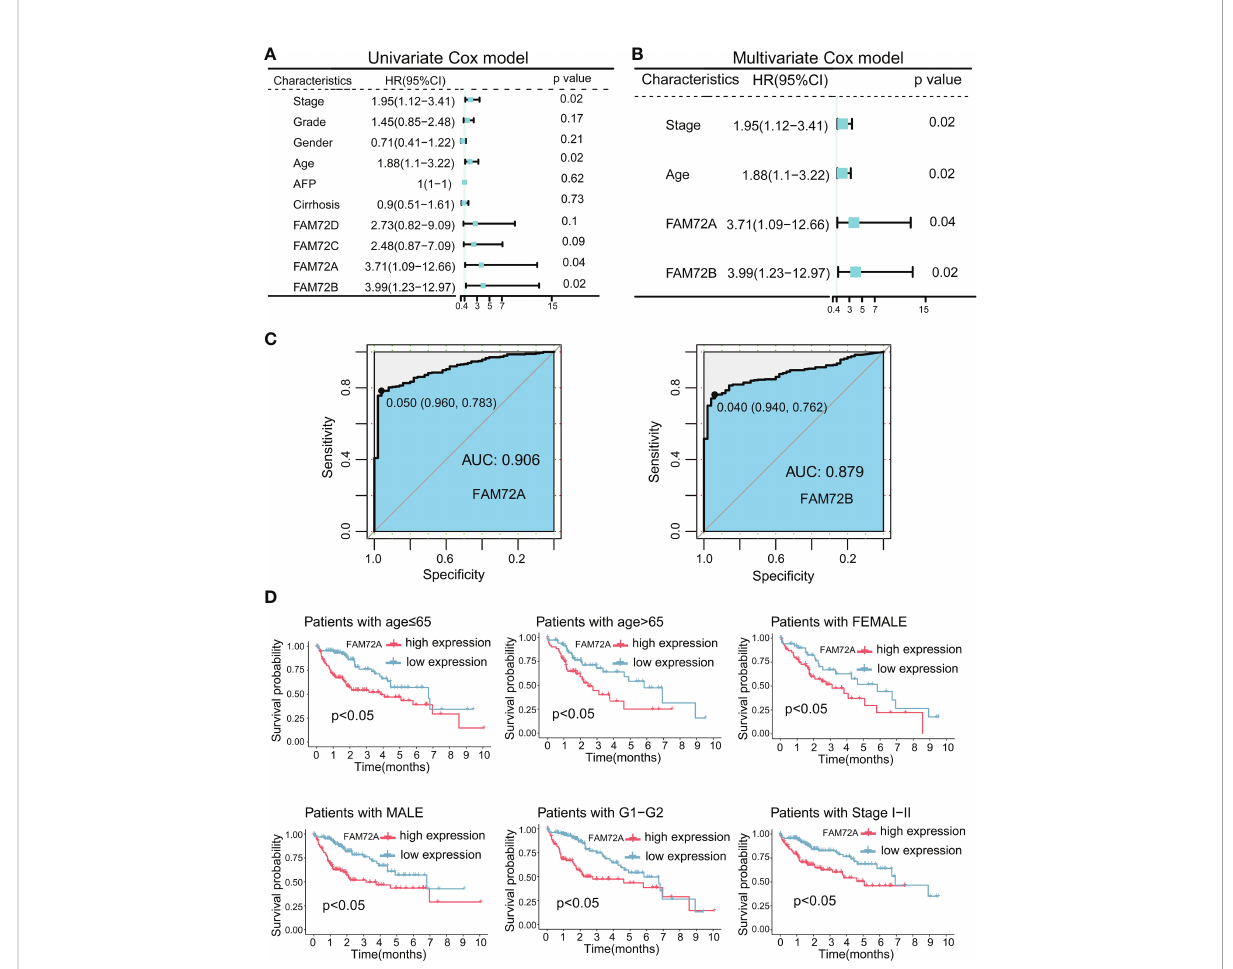
FIGURE 2 Prognostic and diagnostic signi fi cance of FAM72 family genes in TCGA-LIHC cohort. (A) Univariate Cox regression analyses for predicting the OS of HCC patients. (B) Multivariate Cox regression analyses for predicting the OS of HCC patients. Statistical analyses were performed using the Wilcoxon test. (C) ROC curve analysis of the diagnostic values of FAM72A and FAM72B. (D) Kaplan − Meier survival curves comparing the high and low expression of FAM72A in the patients strati fi ed by different clinicopathological characteristics. Statistical analyses were performed using the log-rank test. HR, hazard ratio; OS, overall survival; HCC, hepatocellular carcinoma; ROC, receiver operating